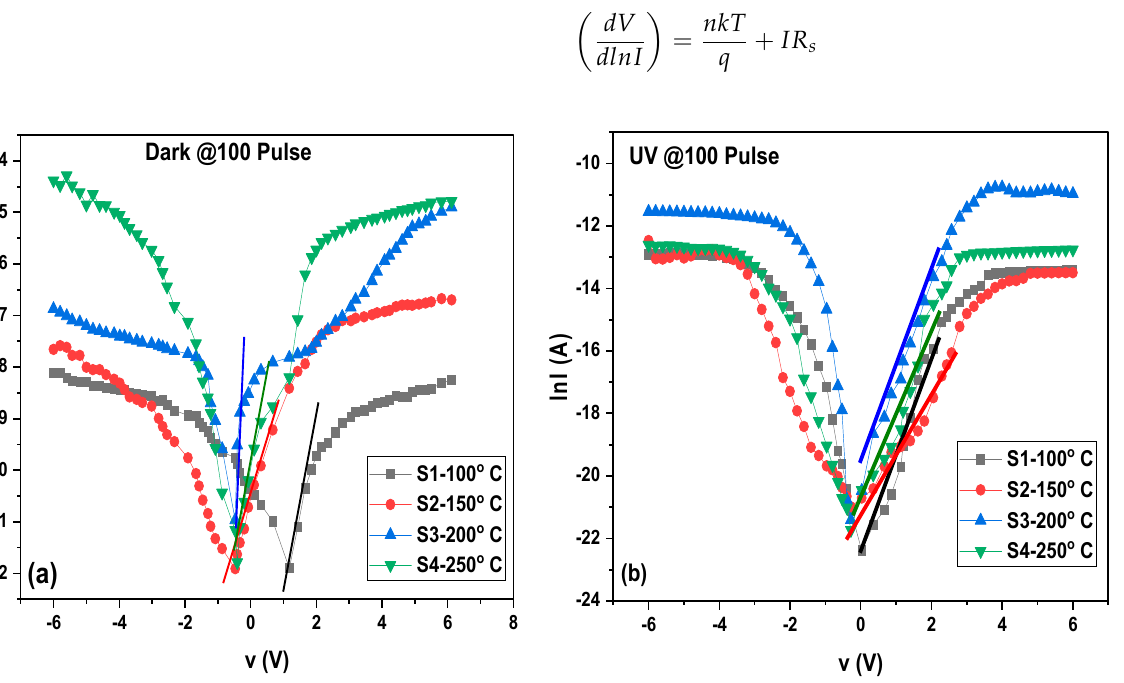
Figure 7. Semi-logarithmic curve of MoO 3 /Si heterostructure photodetector under dark ( a ) and UV irradiance ( b ) of the S1, S2, S3, and S4 samples.